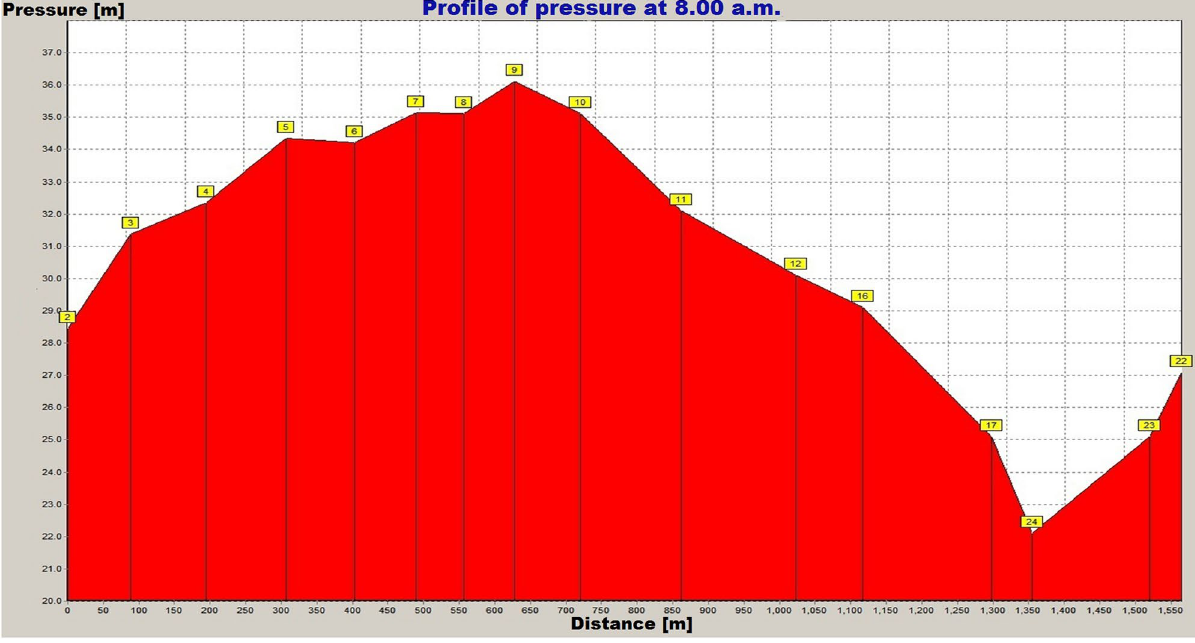
Fig. 10 Pressure profile in the nodes of the main trunk line at the hour of the highest